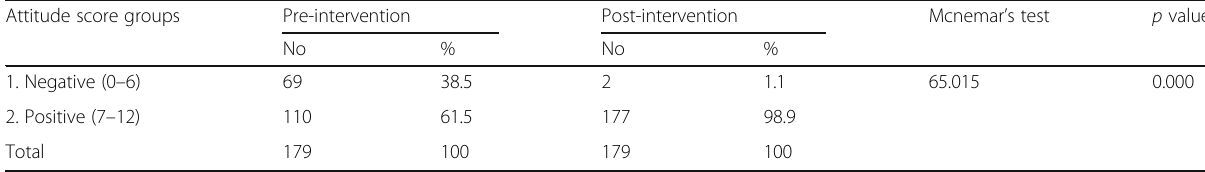
Table 3 Effect of health education intervention on study participants total score of attitude towards HCC and its risk factor prevention Attitude score